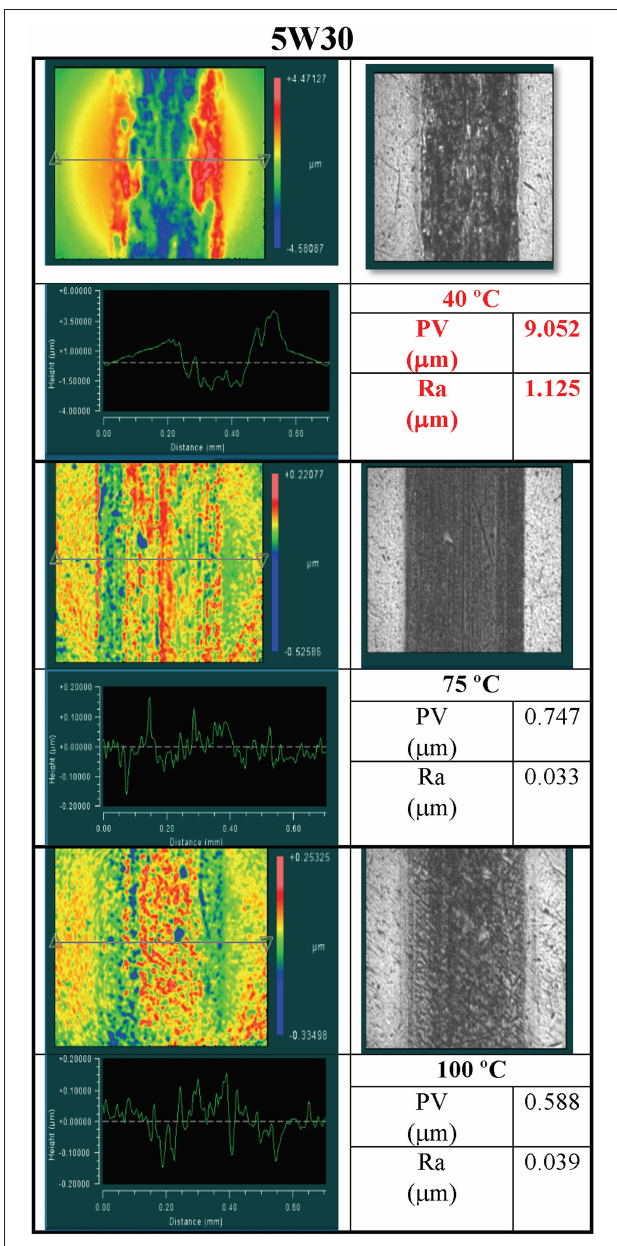
FIGURE 5 | Analysis of wear tracks formed on disks at 40 ◦ , 75 ◦ , and 100 ◦ C in tests performed with the 5W-30 oil. Clockwise in each temperature box are a false color surface map, an optical image of the wear track, the values of PV and Ra in the wear track, and a line trace across the wear track.